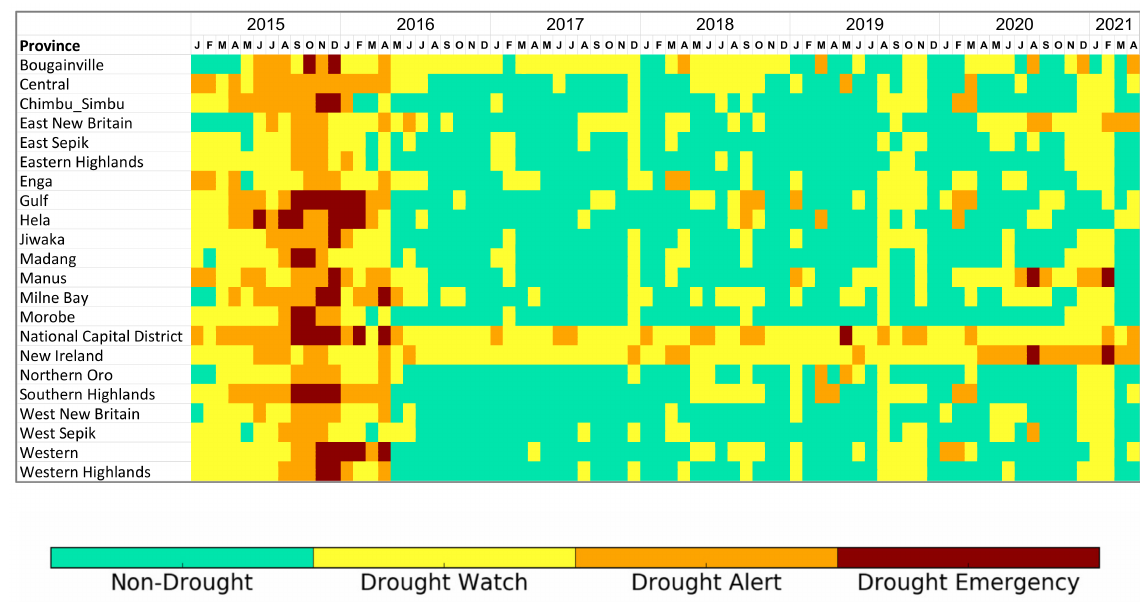
Figure 12. Drought warning status summary for each province in